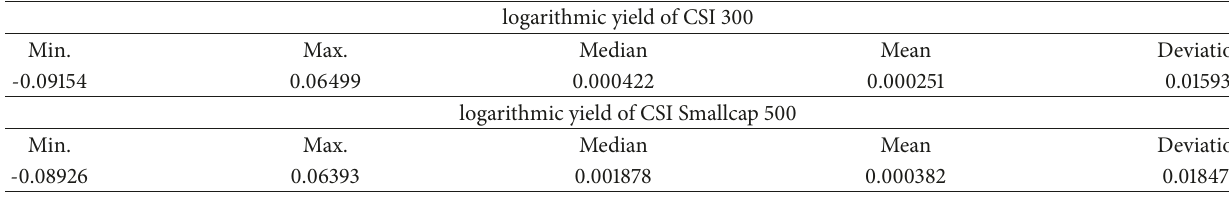
Table 1: The descriptive statistics of stock index.